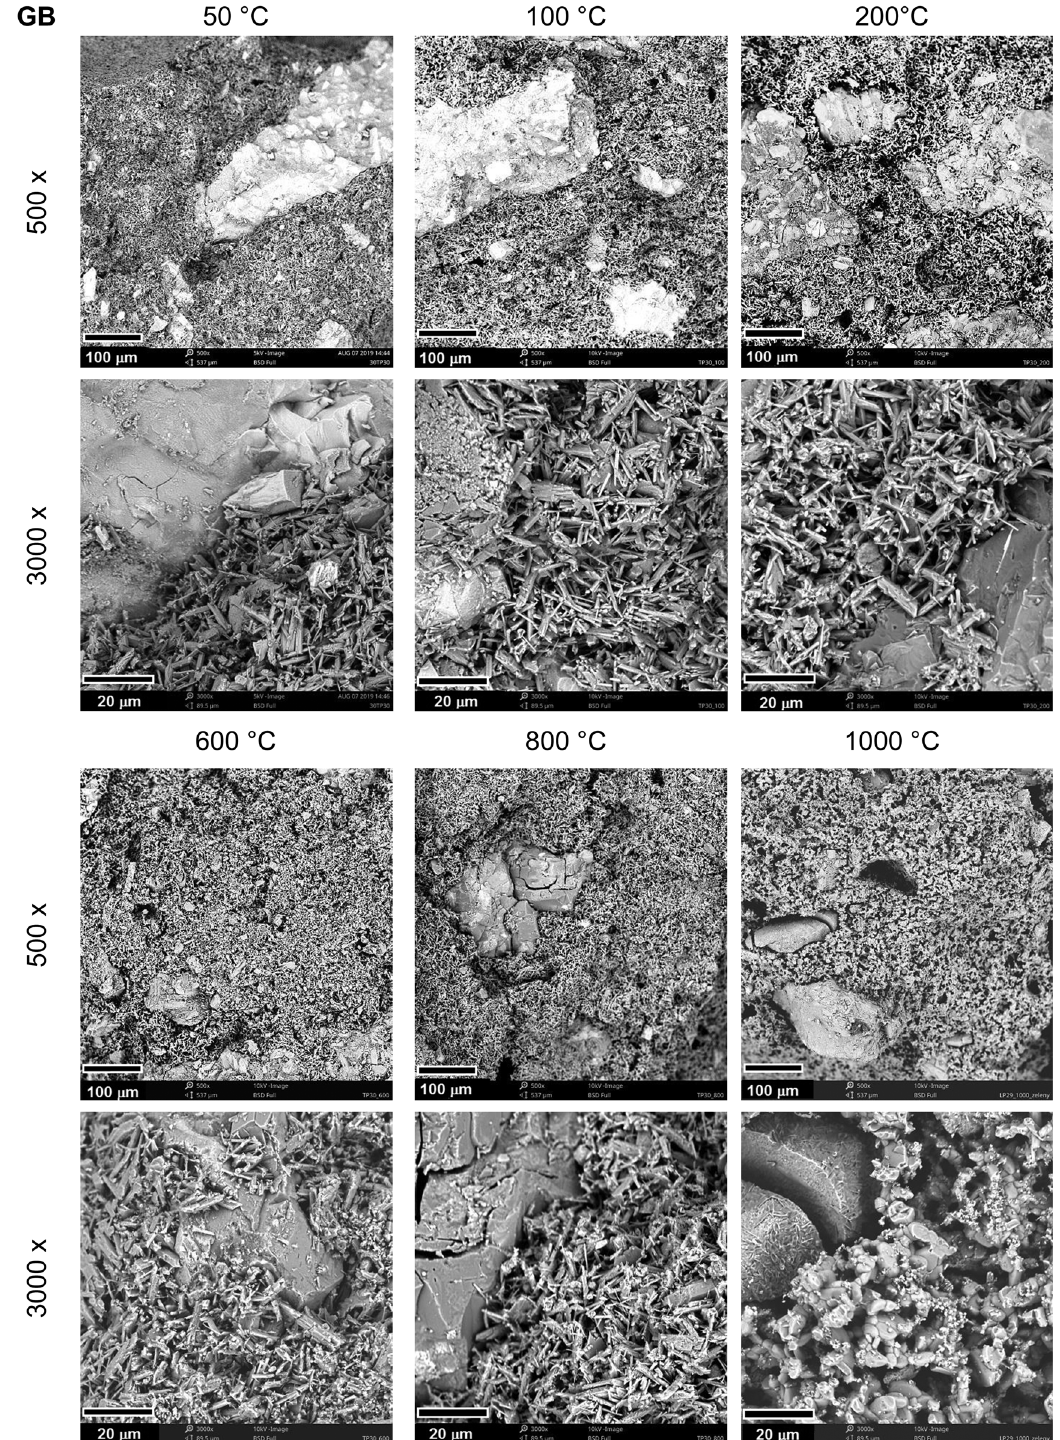
Figure 8: Microstructure of composite with basalt aggregate at selected